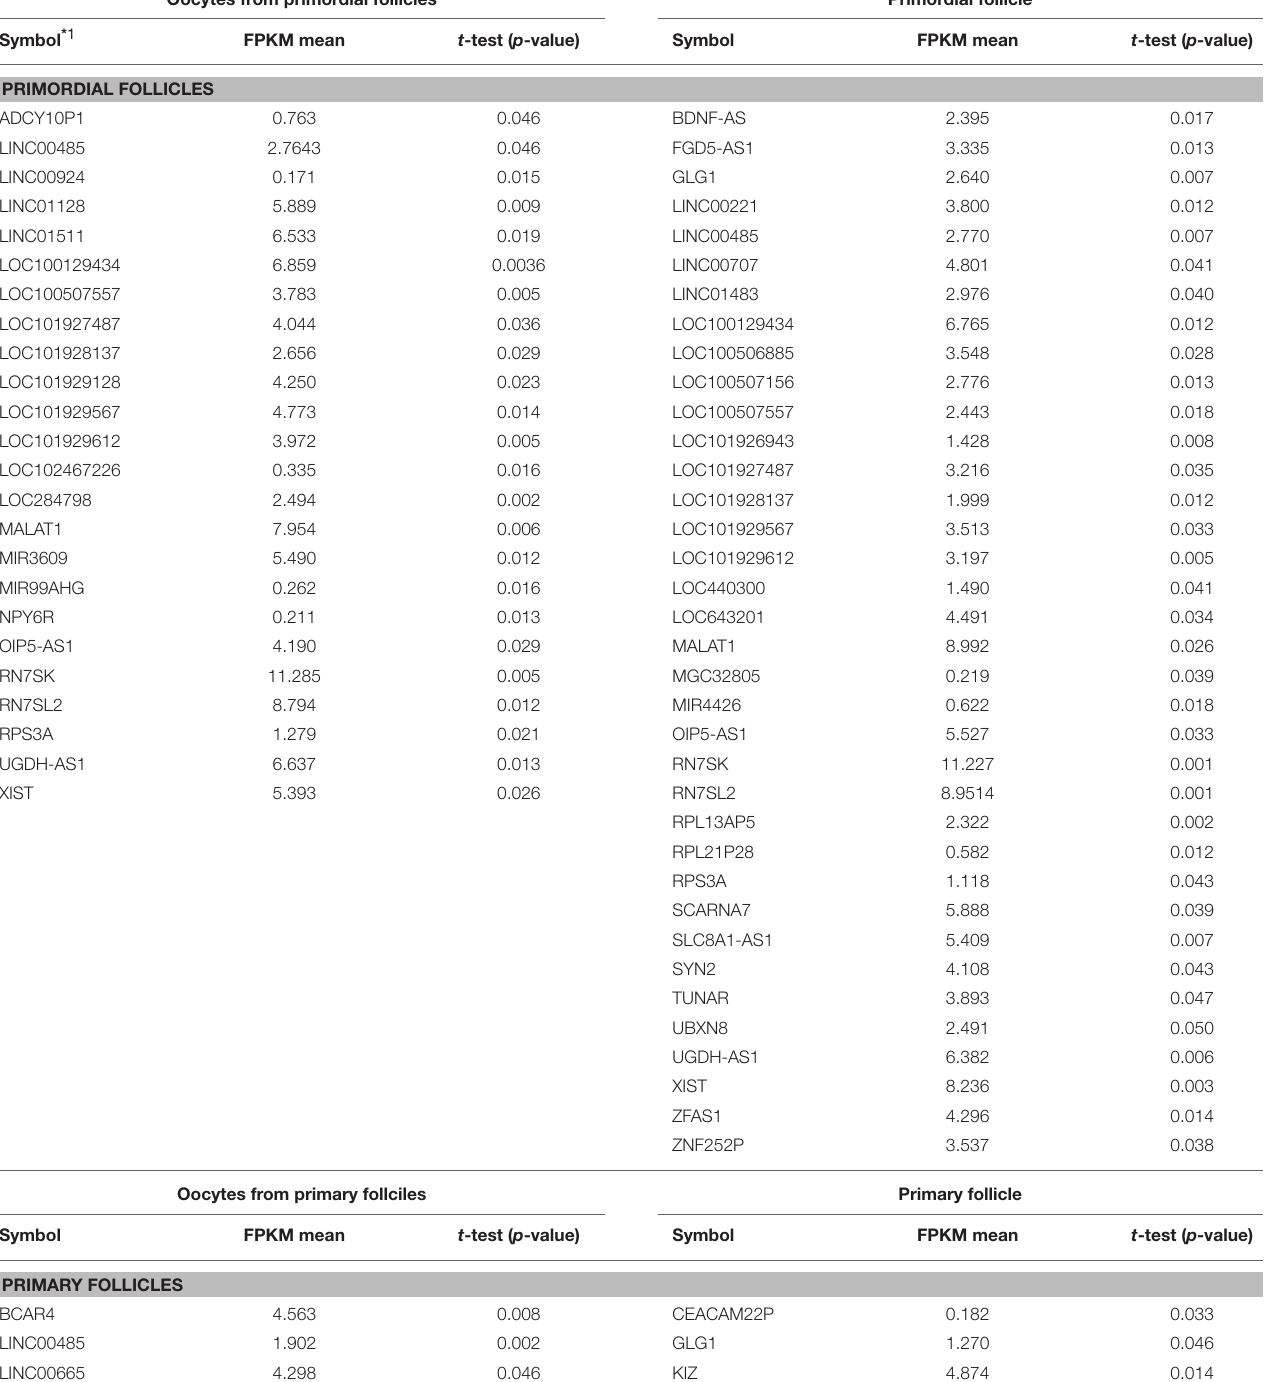
TABLE 3 | Long non-coding RNAs ( p < 0.05) in human follicle development. Oocytes from primordial